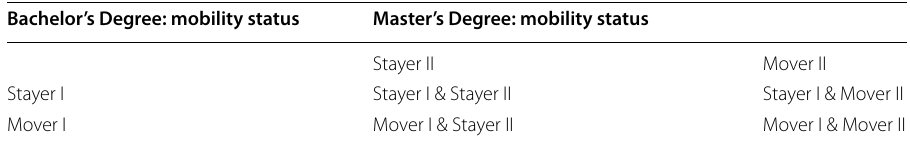
Table 1 Student mobility